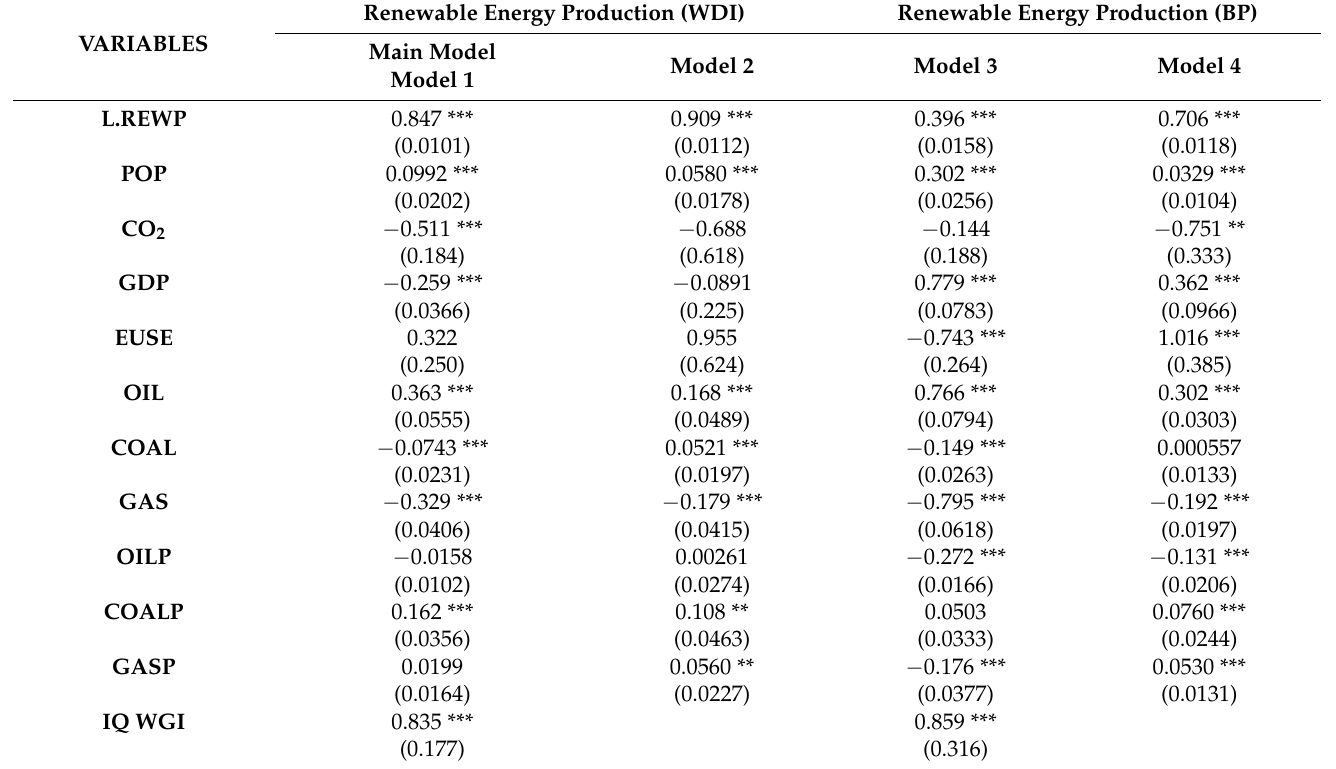
Table 3. Results of institutional quality and renewable energy